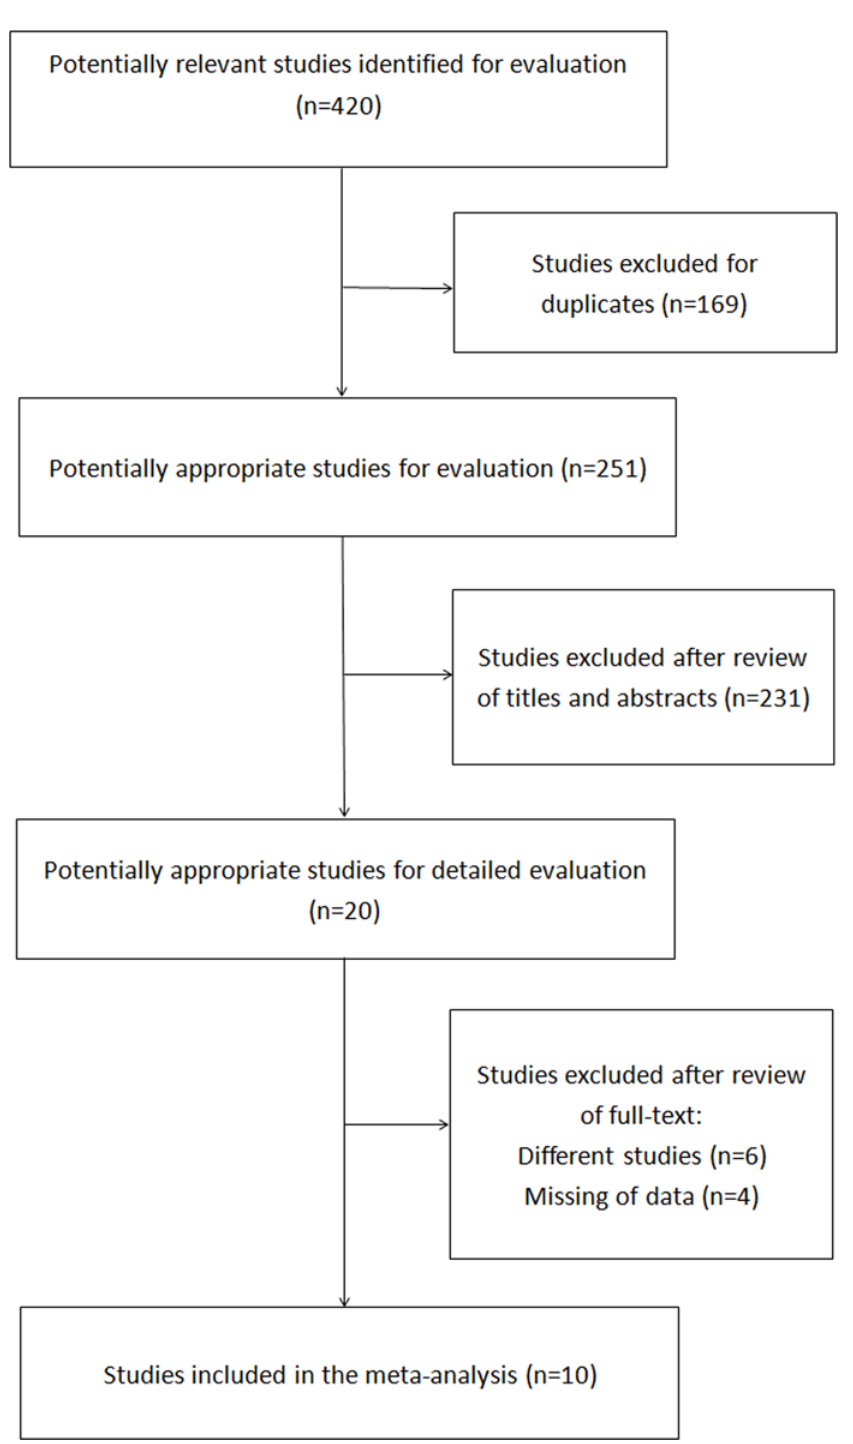
Fig 1. Flow diagram showing the selection process of articles.